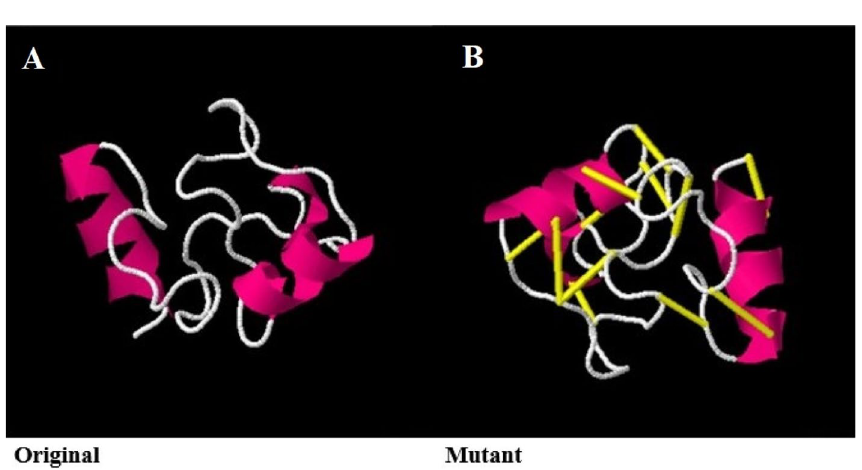
Figure 10. Disulfide engineering of the designed vaccine. The wild type ( A ) as well mutant structure ( B ) are presented. The yellow color stick represents introduced disulfide